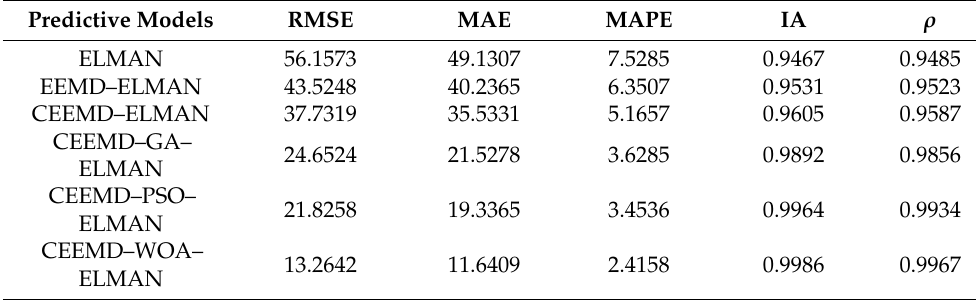
Table 3. Six model error evaluation indicators for wind turbine No. 3. Predictive